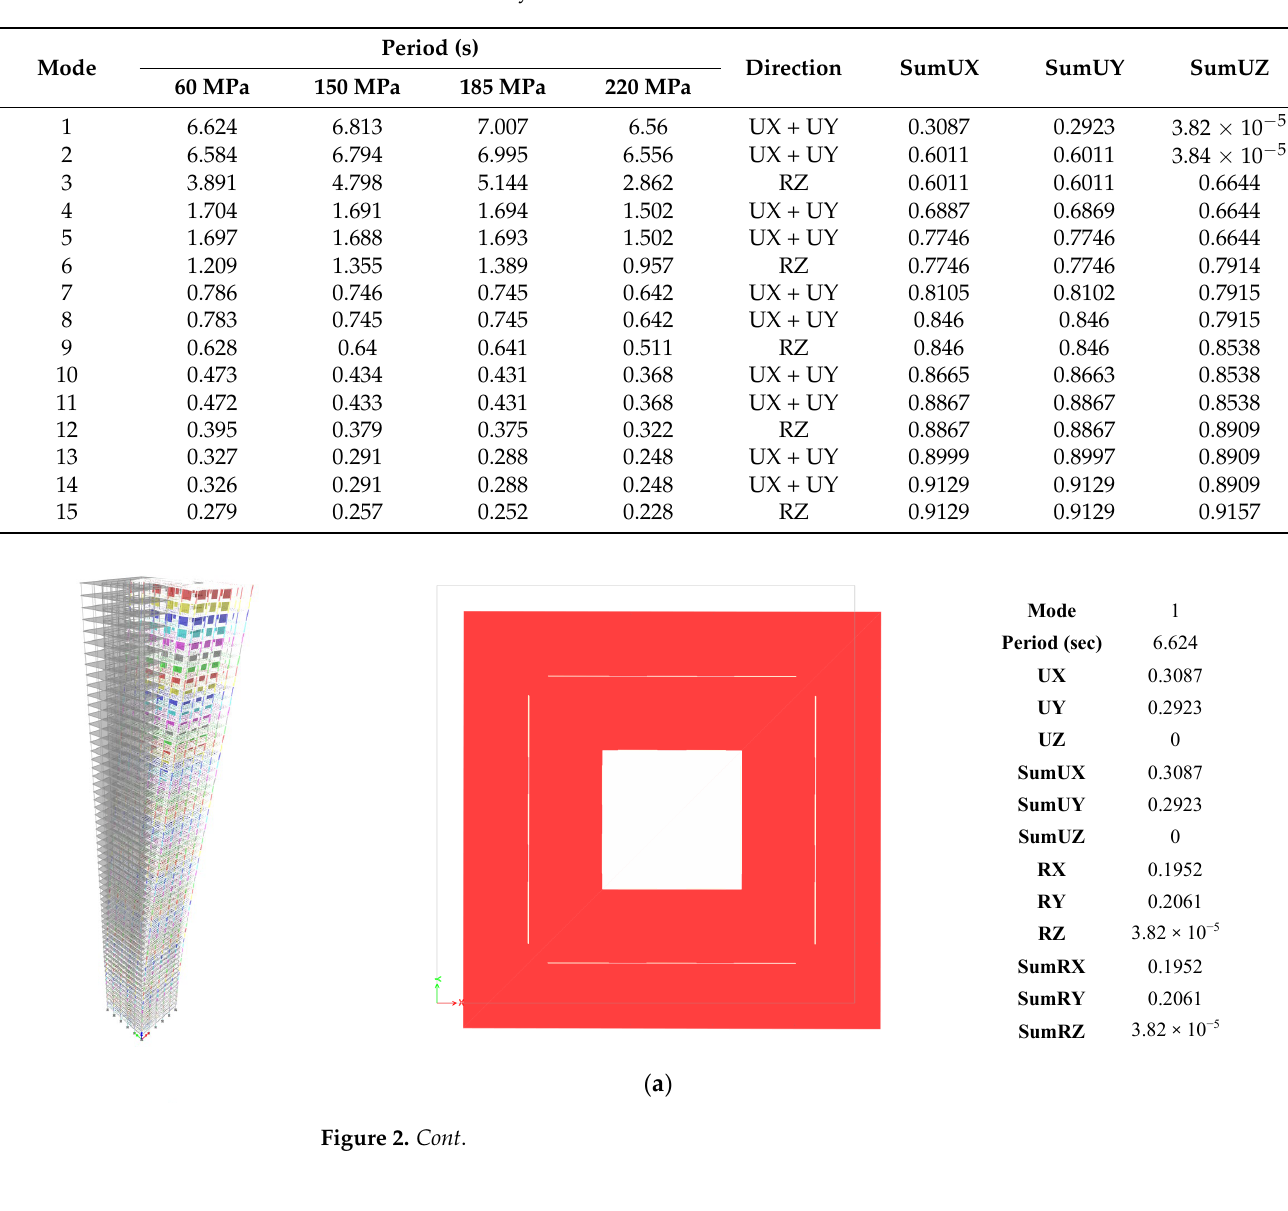
Table 2. Modal analysis results.